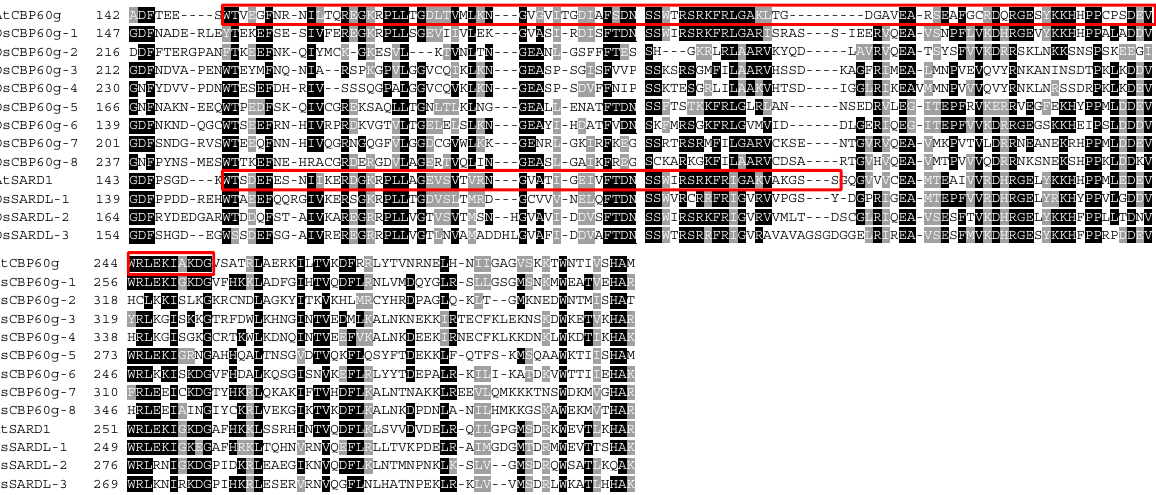
Figure 5. Multiple sequence alignment of the DBDs of AtCBP60g and AtSARD1 proteins with similar regions of OsCBP60g and OsSARDL proteins. The boxed residues indicate the DBD in AtCBP60g and AtSARD1 [47]. The alignment was carried out in CLUSTAL Omega accessed and displayed using Boxshade. Black shading indicates residues conserved in over 50% of the sequences; grey shading indicates semi-conservative substitutions; and the unshaded residues show no similarity.